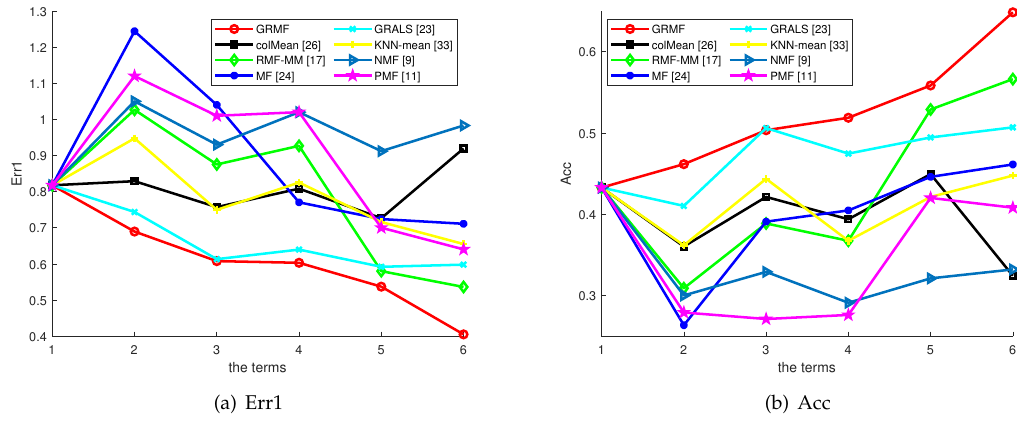
Figure 8. The effects of the parameters of GRMF on the Err1 and